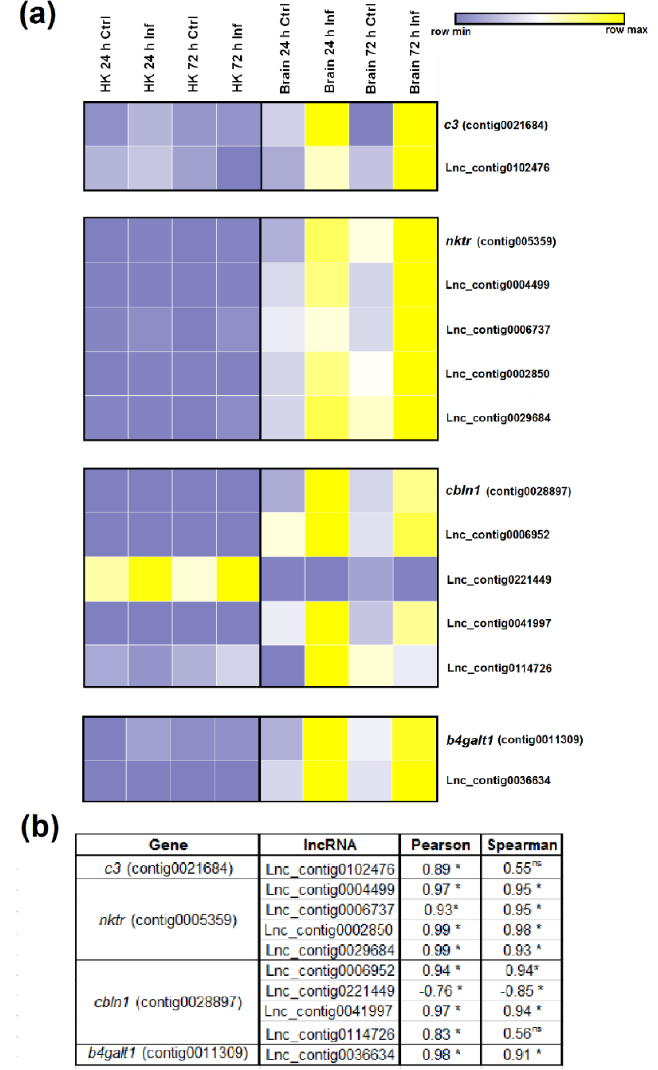
Figure 7. Correlation between differentially modulated coding genes after NNV infection and their flanking lncRNAs. ( a ) Heat map representing the TPM values of four genes and their neighbouring lncRNAs across the different head kidney and brain samples. Expression levels are represented as row-normalised values on a blue–yellow colour scale. ( b ) Correlation values (Pearson’s correlation coefficient and Spearman’s rank correlation coefficient) between the lncRNAs and their nearby coding genes. * represents significant correlation and ns non-significant correlation.